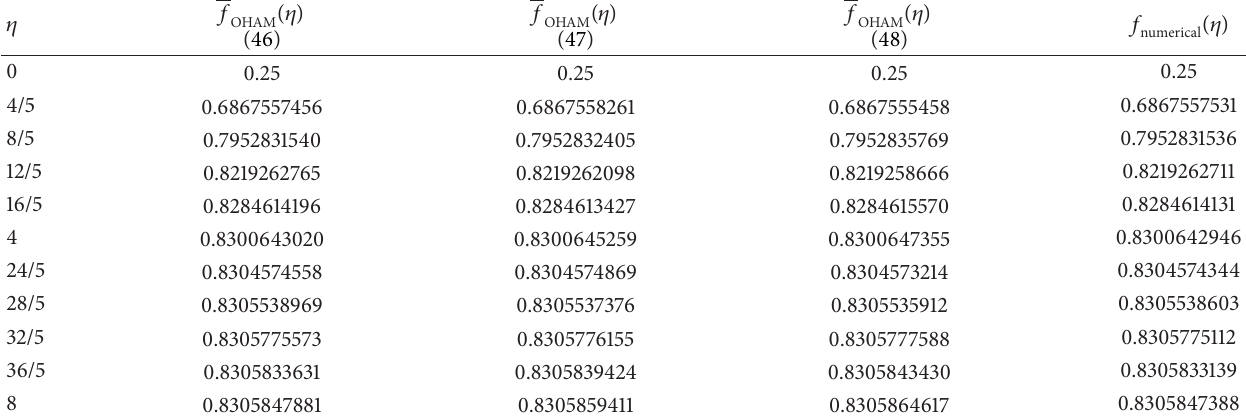
Table 1: Comparison of the first-order approximate solution 𝑓 obtained by OHAM with numerical results.